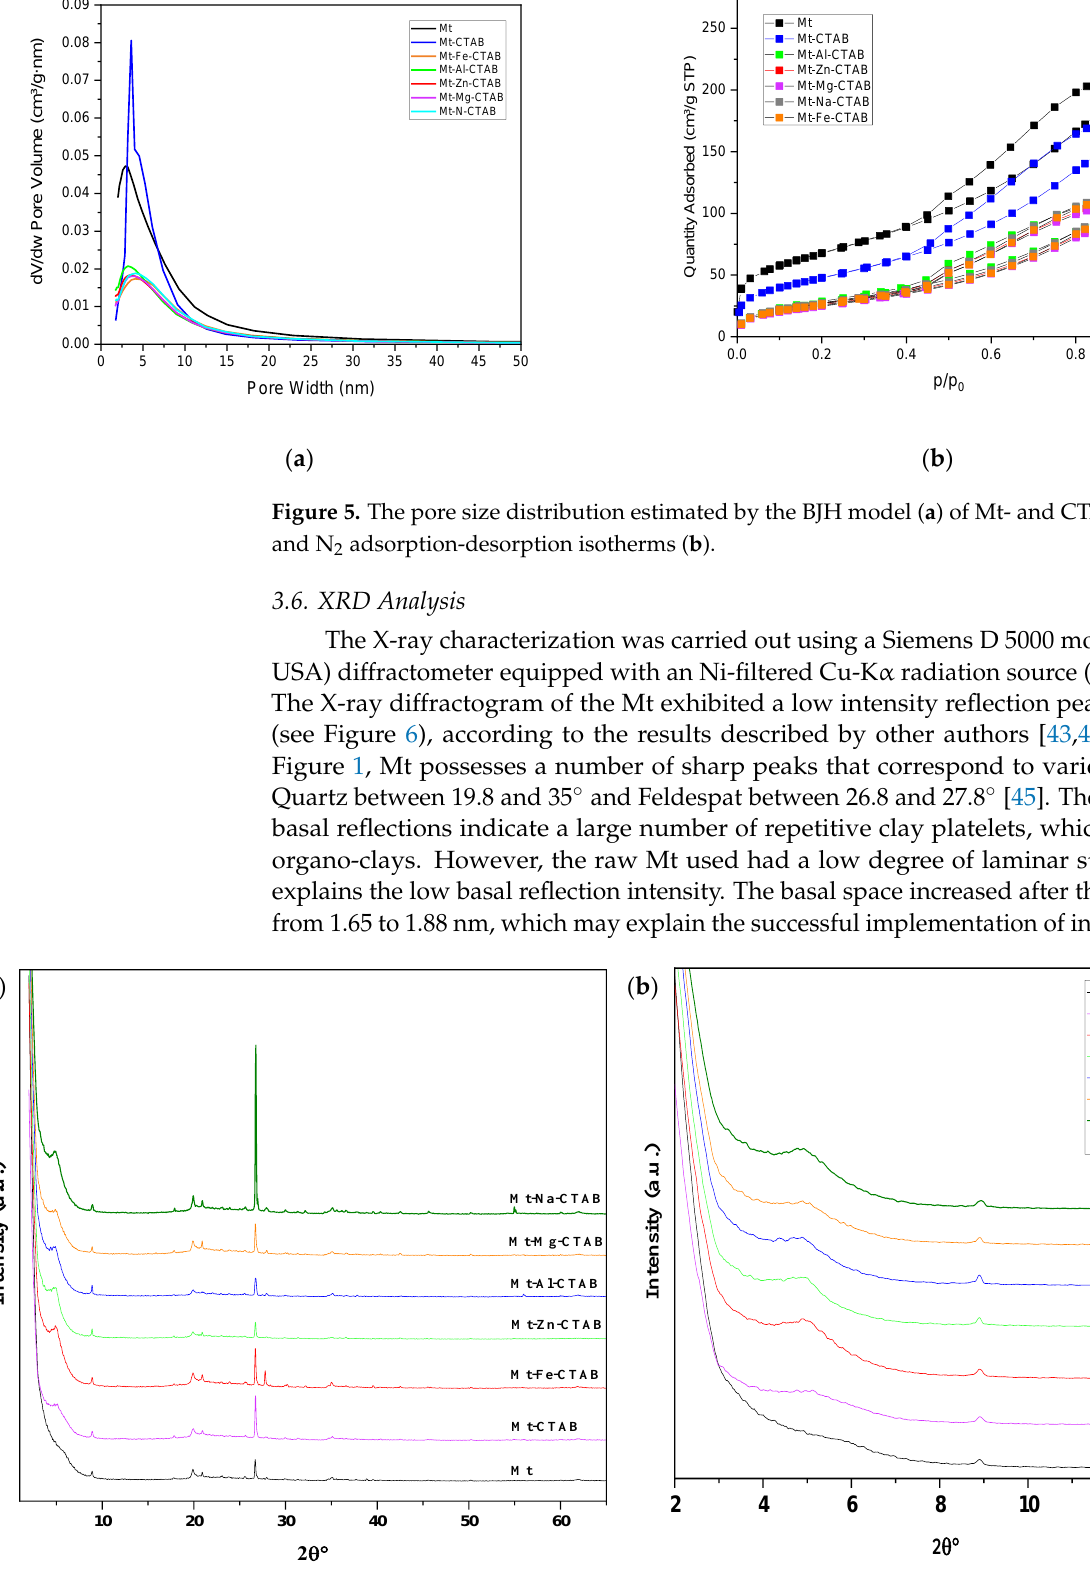
Figure 6. XRD patterns of the Mt- and CTAB-modified Mt. ( a ) range between 2 and 65 ° ; ( b ) low range between 2 and 14 ° .